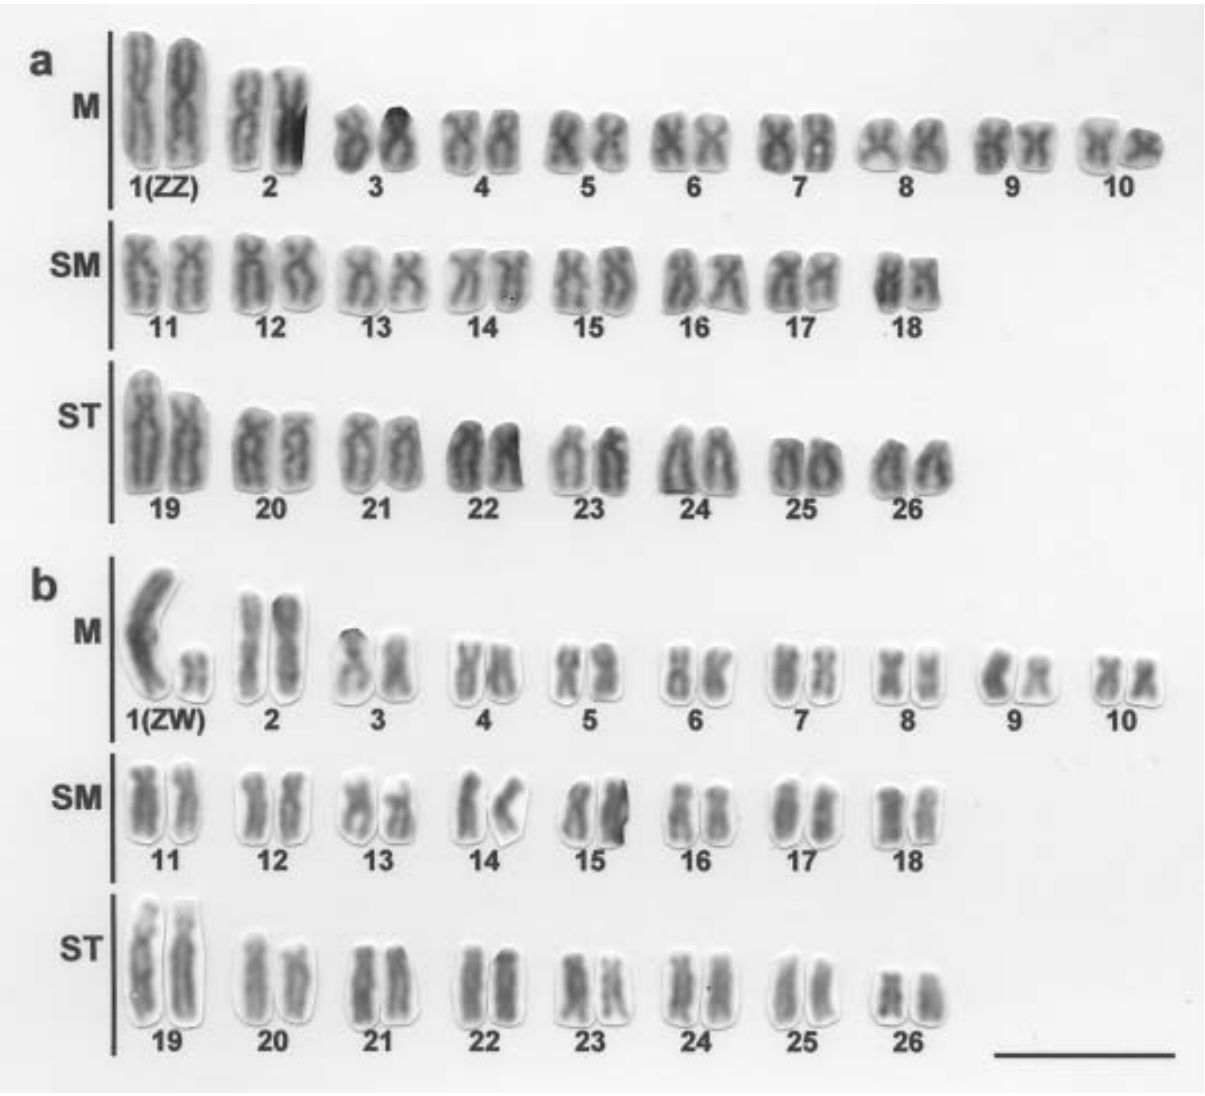
Figure 1 - Giemsa stained karyotypes of a male (a) and a female (b) Triportheus venezuelensis . Bar = 10 μ